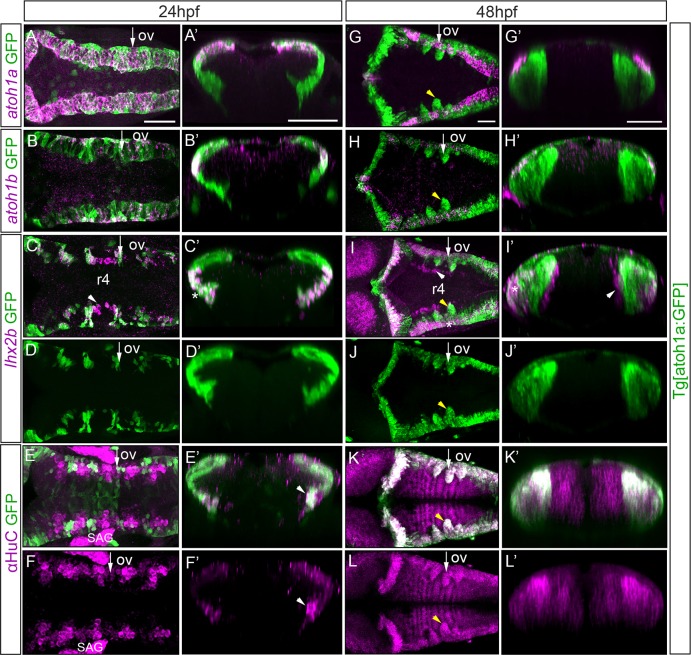
Analysis of the atoh1a neuronal derivatives in Tg[atoh1a:GFP] embryos.Tg[atoh1a:GFP] embryos at 24hpf and at 48hpf were assayed for atoh1a (A, G), atoh1b (B, H), lhx2b (C-D, I-J) in situ hybridization, and anti-HuC (E-F, K-L) staining. Dorsal views of confocal MIP from dorsal stacks (A-B) or ventral stacks (C-L) with anterior to the left. A’-L’) Reconstructed transverse sections of the dorsal views in (A-L) at the level indicated with the white arrow depicted in (A-L) corresponding to r4/r5. All embryos displayed the atoh1a-progenitors and derivatives in green. Note that atoh1b cells derive from atoh1a:GFP progenitors (B’, H’), as well as the lateral lhx2b neuronal domain (see white asterisks in C’, I-I’), whereas the medial lhx2b neuronal column in r4 is devoid of green staining (see white arrowhead in C, I-I’). See that differentiated neurons organize in arch-like structures (yellow arrowhead in G-L). ov, otic vesicle; SAG, statoacoustic ganglion; r, rhombomere. Scale bars correspond to 50 μm.